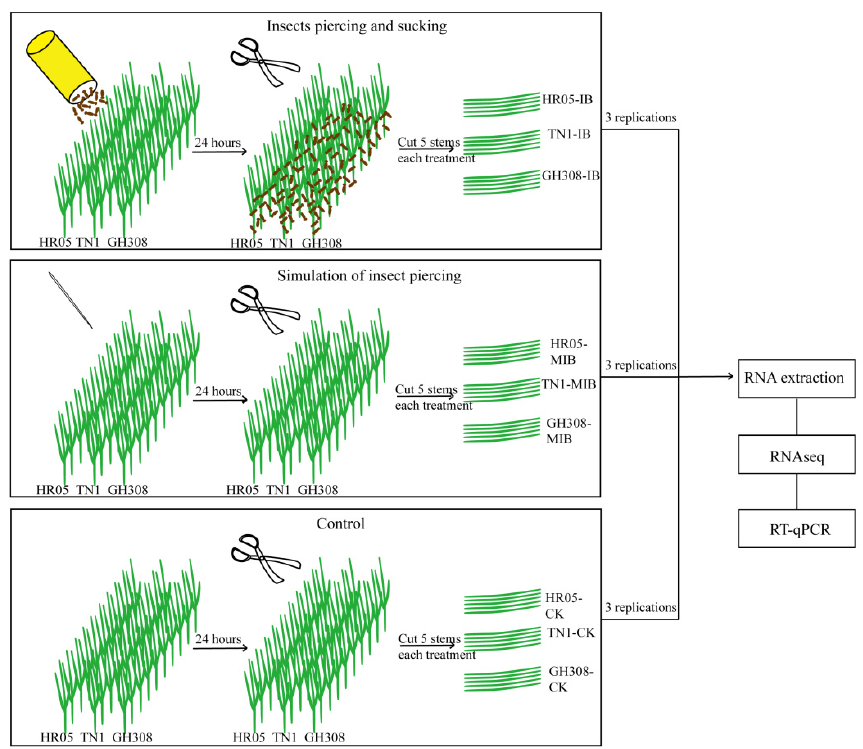
Figure 1. Experimental flow chart. Sample collection, transcriptome sequencing, and bioinformatics analysis. Three rice cultivars (GH308, HR05, and TN1) were exposed to BPH feeding and subjected to mechanical damage to simulate insect piercing, or kept unharmed (control). After 24 h, the stems were collected for transcriptome analysis ( n = 3).